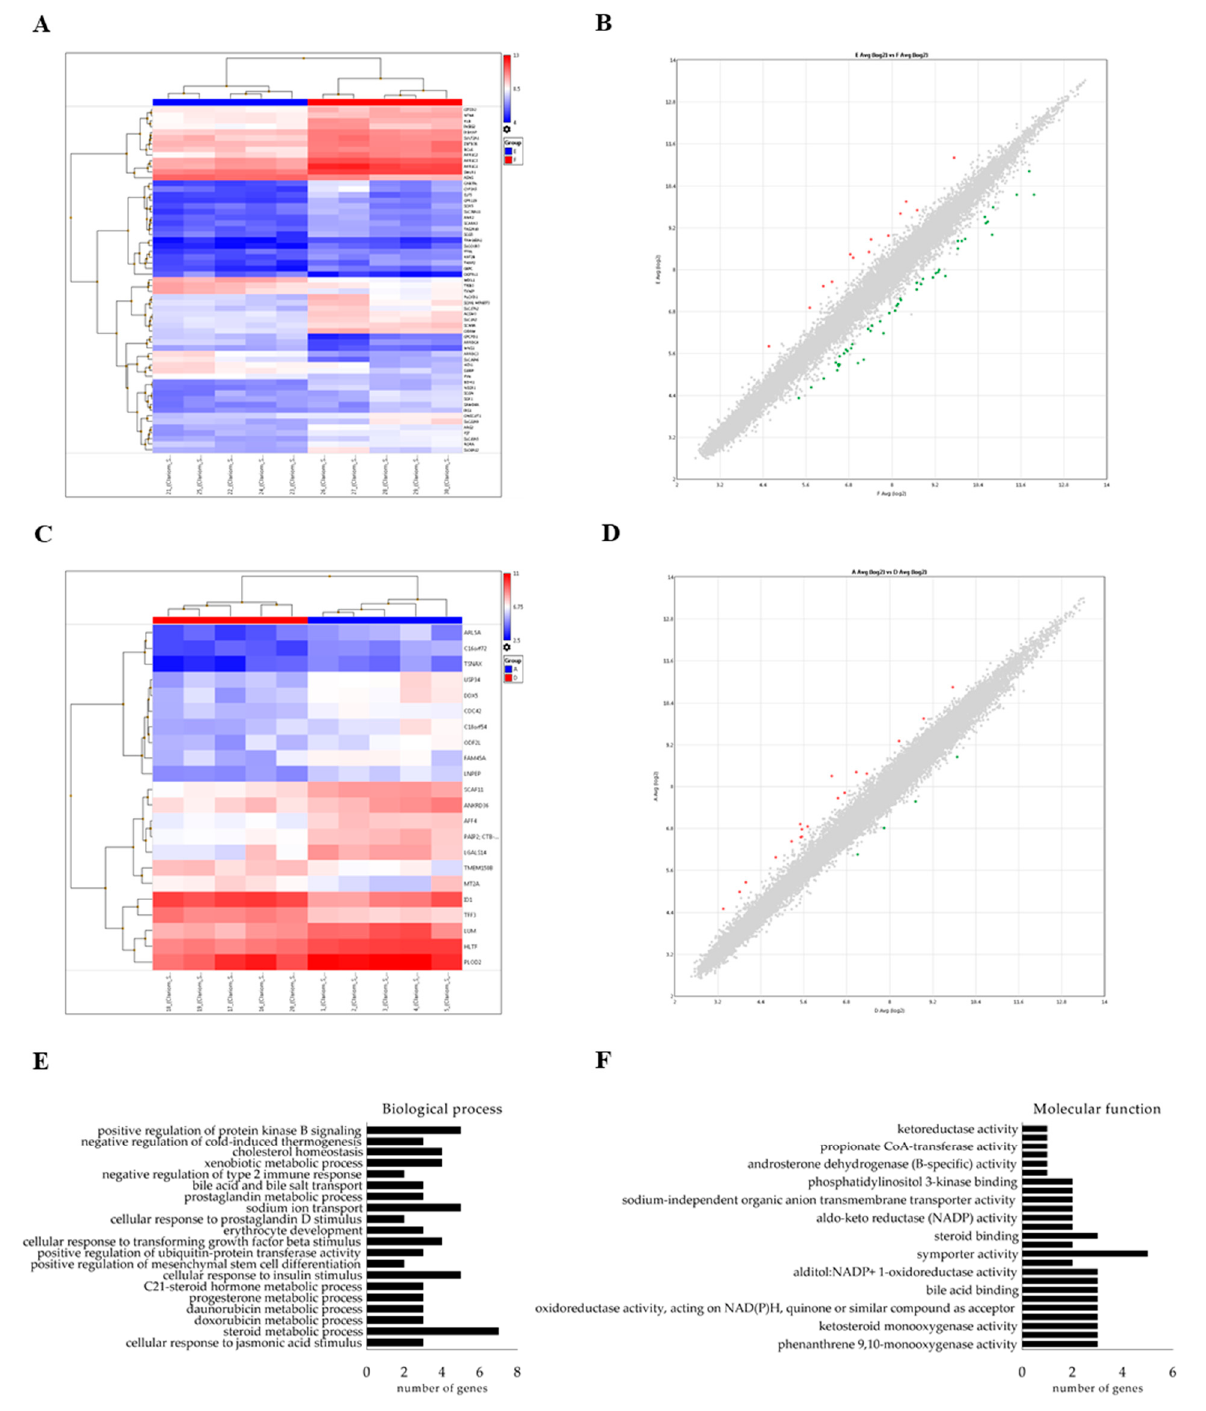
Figure 5. ( A ) Hierarchical clustering of HepG2 gene profiles after exposure to hsa-miR-148a-3p (TE) or mimic negative control miRNA (TNC), during 24 h. ( B ) Scatter plot of differentially expressed genes in HepG2 cells. ( C ) Hierarchical clustering of Caco-2 gene profiles after exposure to hsa-miR-148a-3p or mimic negative control miRNA, during 24 h. ( D ) Scatter plot of differentially expressed genes in Caco-2 cells. ( E ) In-silico analysis of the possible biological processes occurring after the exposure to hsa-miR-148a-3p. ( F ) In-silico analysis of the possible molecular functions involved in the response to hsa-miR-148a-3p exposure.